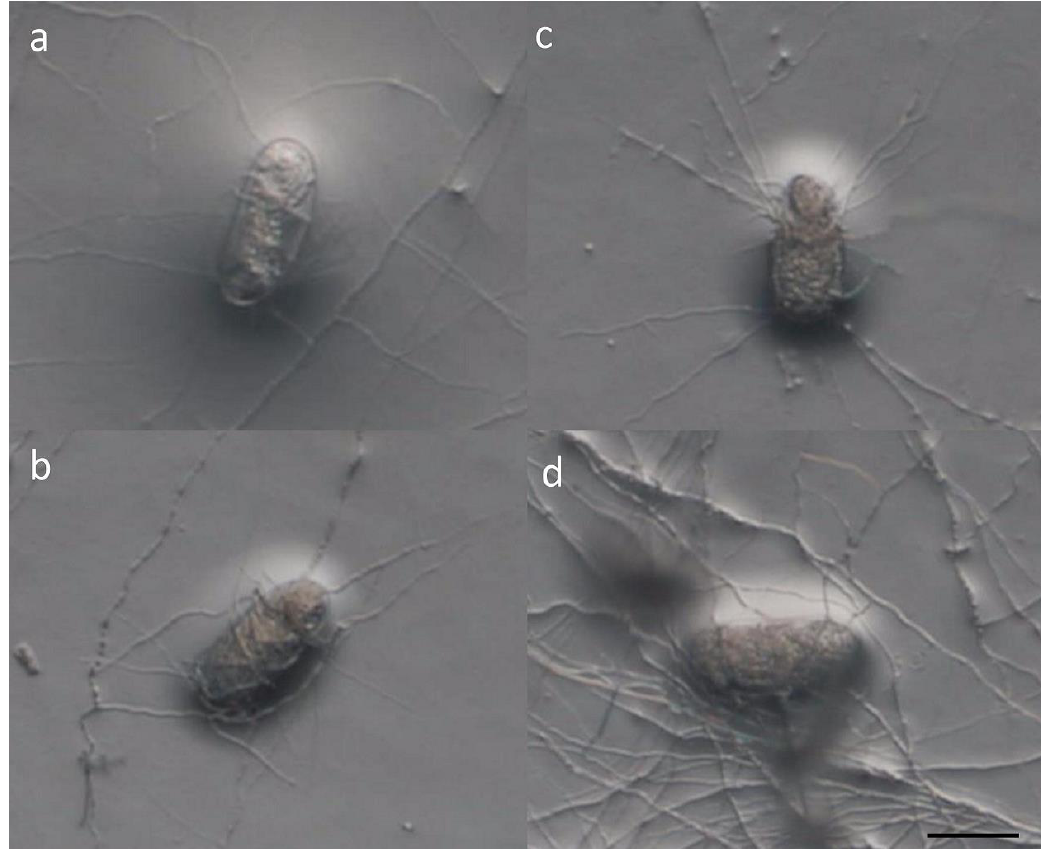
Table 1. Effects of the nematophagous fungi on M. enterolobii egg hatching and infection rate.